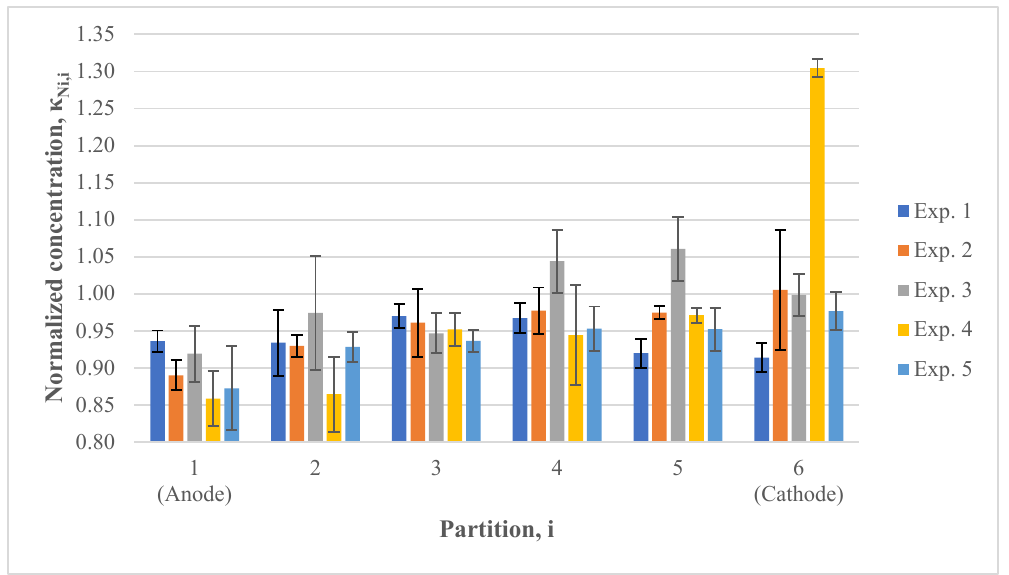
Figure 5. Total nickel concentration profiles.